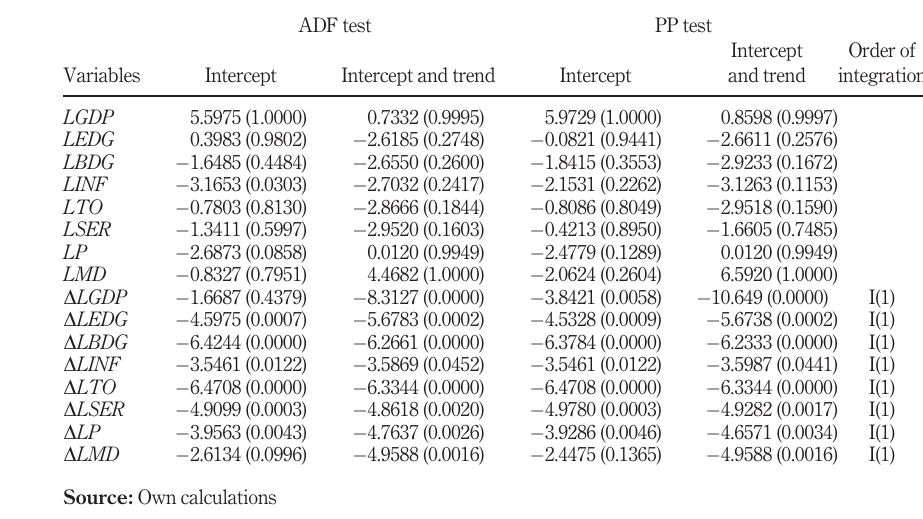
Table 5. Unit root